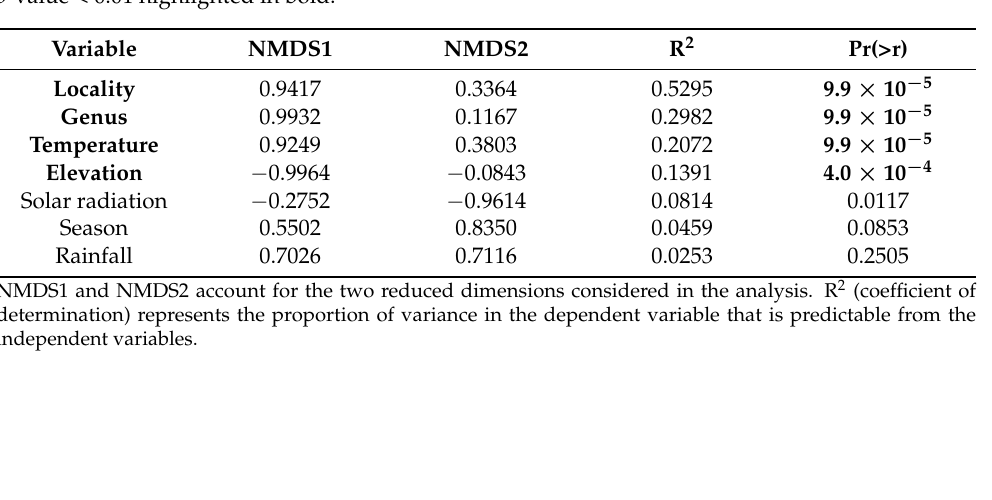
Table 4. Non-metric multidimensional scaling (NMDS) model statistics obtained by the correlation between the metabolic fingerprints of 109 taxa of Espeletiinae (representing 4181 variables) and their locality of collection, taxonomy, and climate as supplementary variables. Variables with a p -value < 0.01 highlighted in bold.